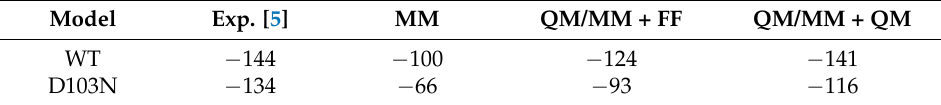
Table 1. Calculated electric fields on the C=O group of 19-NT (in MV/cm) with various computational methods. The experimental values were obtained from Fried et al. [5]. “MM” denotes that the calculation is based on the classical force field simulations and calculation of electric fields using the charge model of the Amber ff99SB force field. “QM/MM + FF” denotes that the calculation is based on the QM/MM simulations and the calculation of electric fields with the charge model of the Amber ff99SB force field. “QM/MM + QM” denotes that the calculation is based on the QM/MM simulations and full QM calculation of electric fields using the single-snapshot approach with the EE-GMFCC